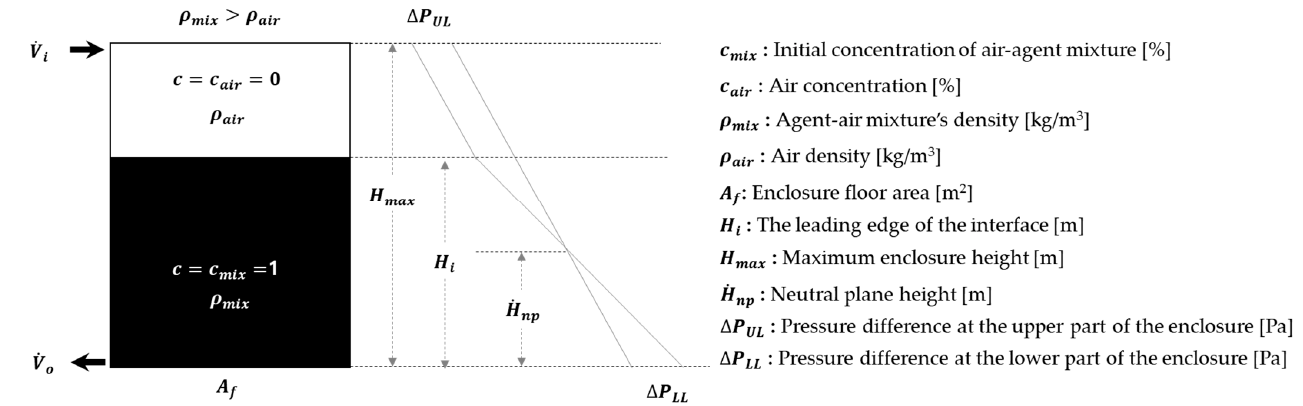
Figure 1. Schematic diagram of hydrostatic pressure profile of the sharp model.